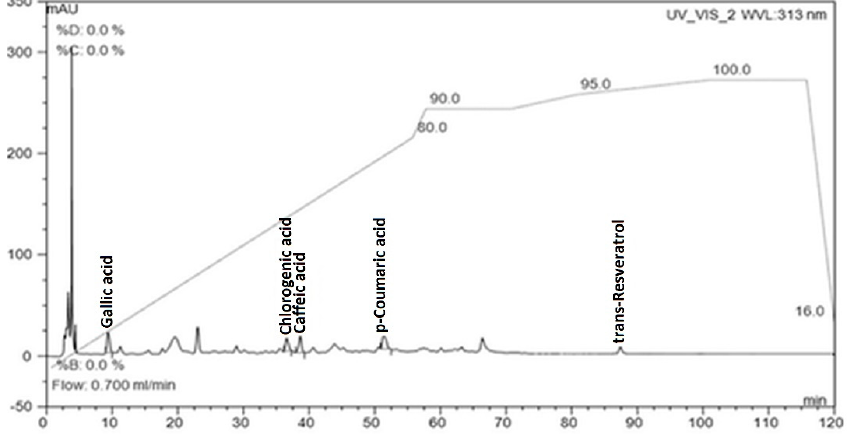
Figure 1. Chromatogram of blackberry wine sample (CBW4) recorded at 313 nm for phenolic acids and trans -resveratrol.